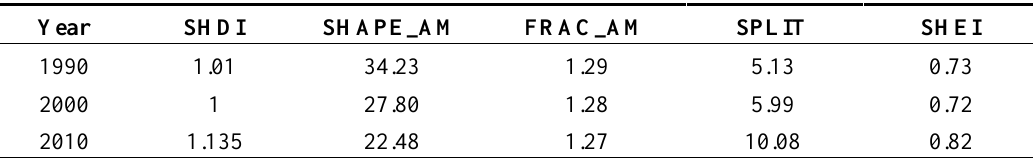
Table 4. Landscape-level indexes from 1990 to 2010.